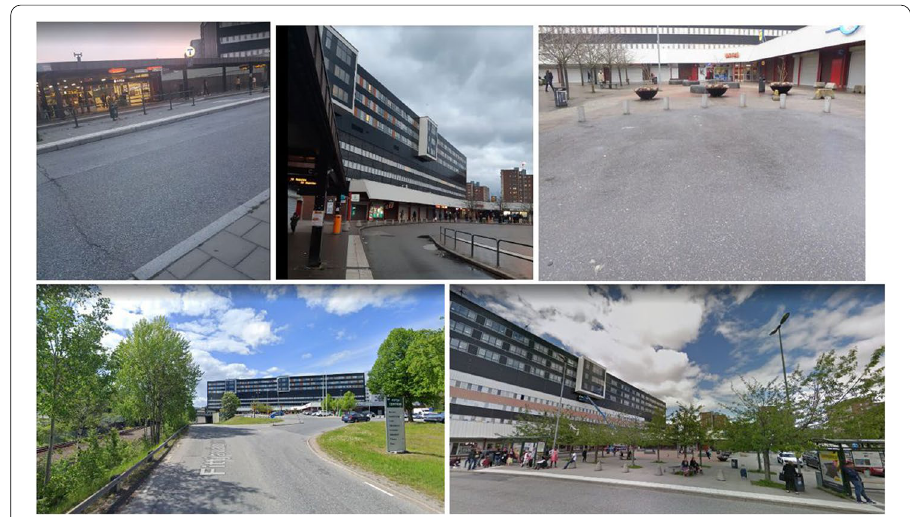
Fig. 3 Images of Fittja square and its street- and bus area (Photo A : Zafer Akdag 2017 Google, Photo B : Alexander Zvir 2019, Google, Photo C : Tillgänglighetsdatabasen 2018, Photo D : Google maps, Photo E : Google Maps)